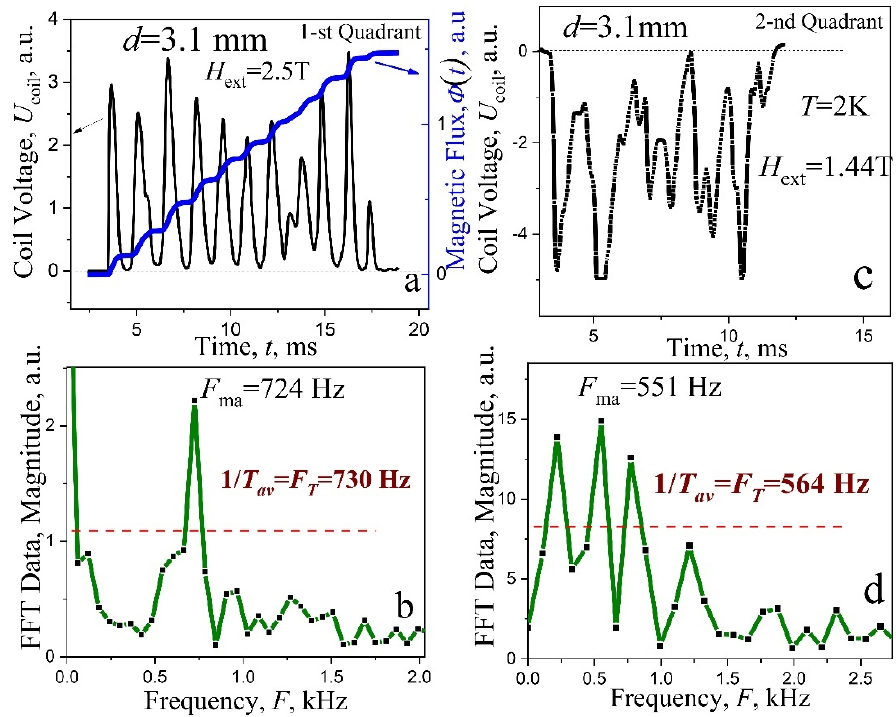
Figure 7. ( a , c ) The voltage impulse U coil ( t ) at the avalanche in trapping ( a ) and screening ( c ) regime (left ordinate) and multi-step “stairway” structure of magnetic flux Φ ( t ) [right ordinate in ( a )]; ( b , d ) magnitude data from fast Fourier transformation of signal U coil ( t ); d = 3.1 mm, T = 2 K.